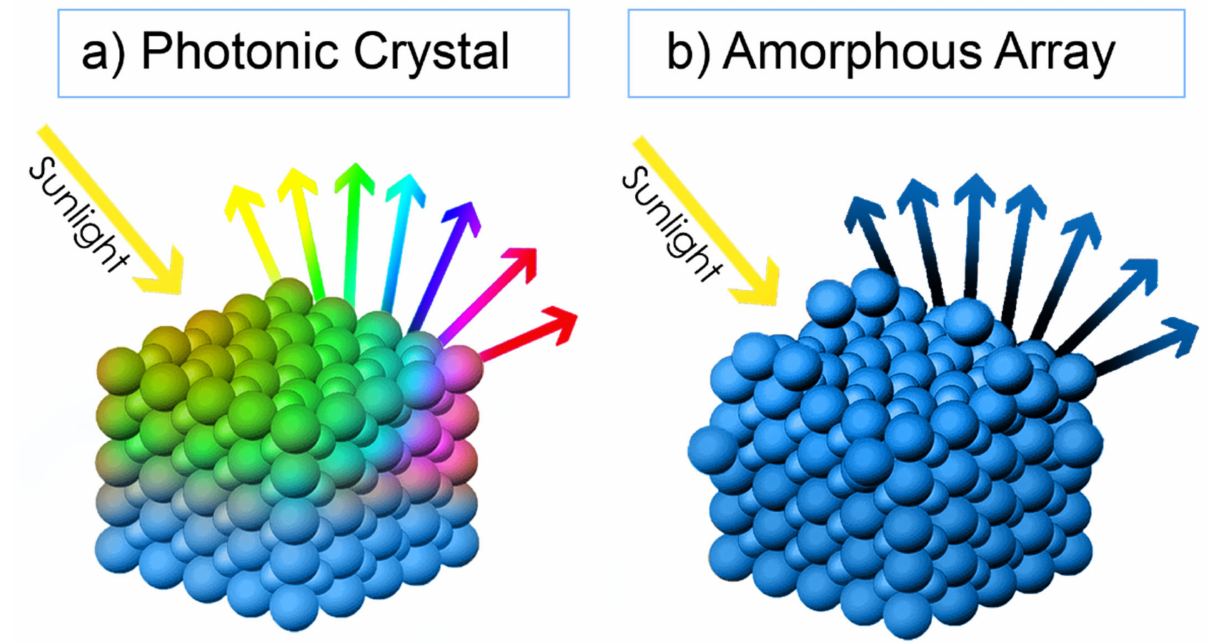
Figure 7. Schematic optical interaction of ( a ) an ordered colloidal crystal and ( b ) an amorphous colloidal array under white light. The structural color from the colloidal crystal changes depending on the viewing angle, while that of the amorphous array remains nearly